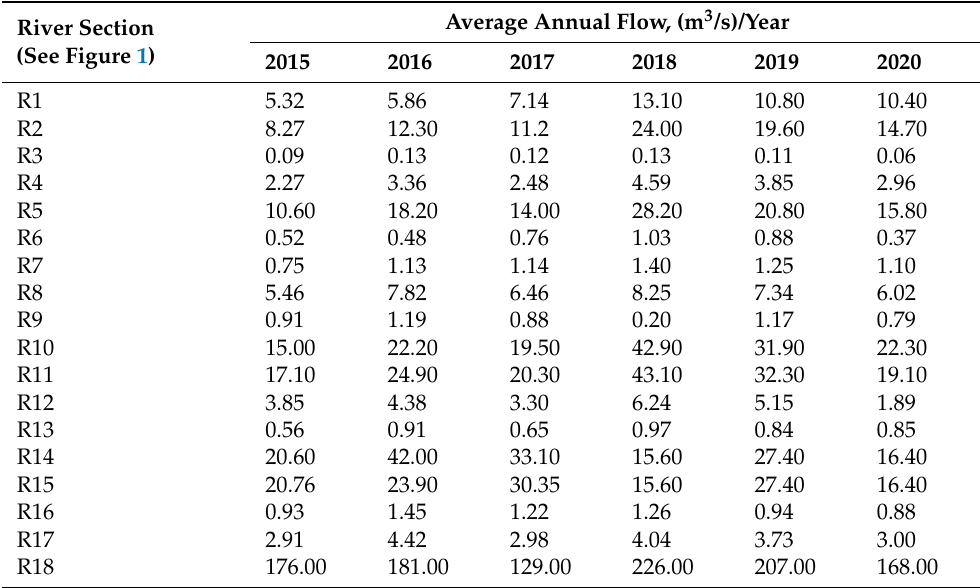
Table 1. The average values of the river’s multiannual flow in the monitored sections. River Section